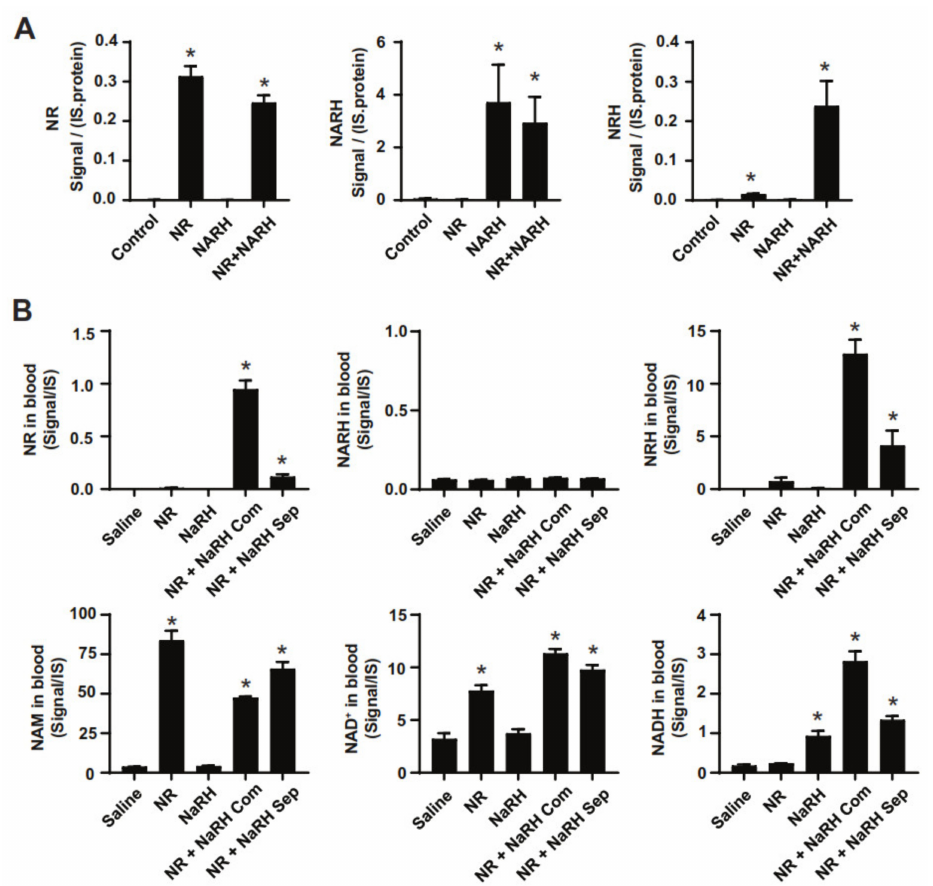
Figure 5. The NR + NARH combination leads to the generation of NRH. ( A ) AML12 were treated with either PBS (as control), NR (0.5 mM), NARH (0.5 mM) or both. Then, 2 h later, cells were flash-frozen and processed for metabolomic analyses. ( B ) After a 2 h fast, mice were intraperitoneally injected with saline (as vehicle) or 500 mg/kg of NR, NARH, or NR+NARH. For the NR+NARH combination, we had one group in which both compounds were injected using a single mix with both compounds and a second group where the compounds were injected separately. One hour later, blood was collected and the blood levels of different NAD + -related metabolites were evaluated. All values are presented as normalized LC-MS signal intensities, mean +/ − SEM of n = 3 independent samples/group ( A ) or n = 5 mice per group ( B ). * indicates p < 0.05 vs. the control ( A ) or saline-injected ( B )